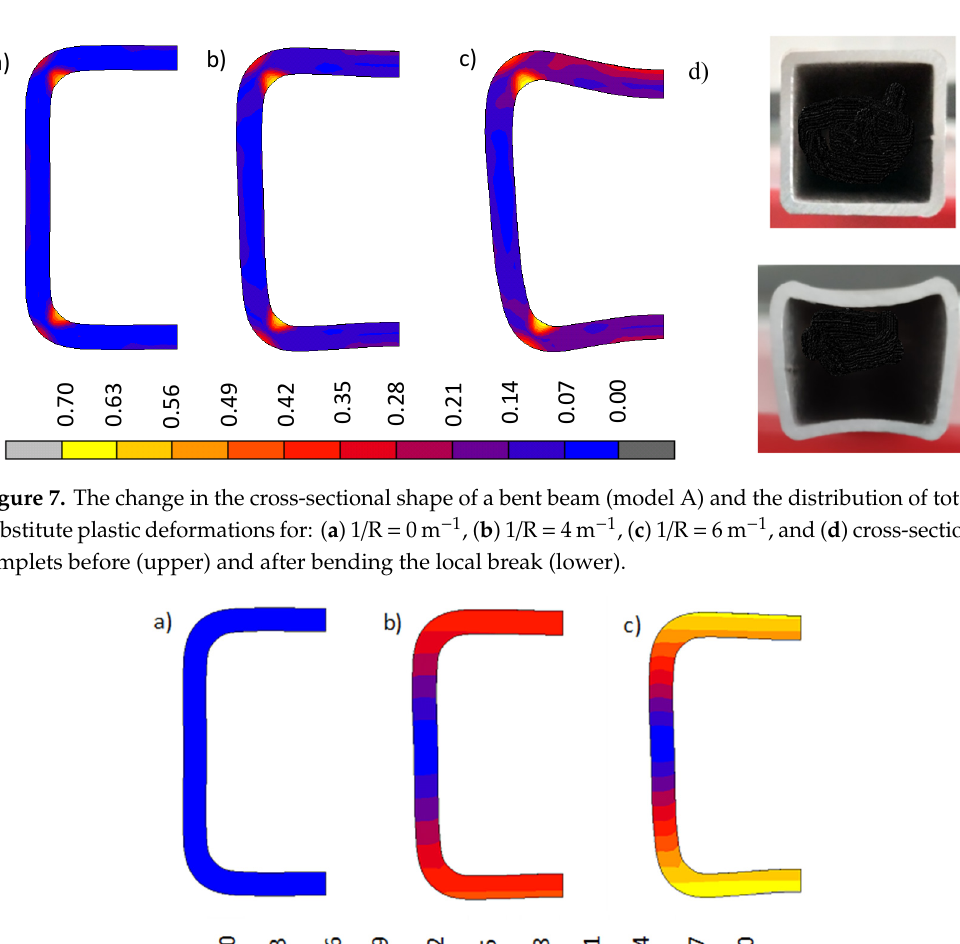
Figure 9. The effect of bending curvature when deflecting the horizontal walls of the 25 × 25 × 2 square steel pipe.